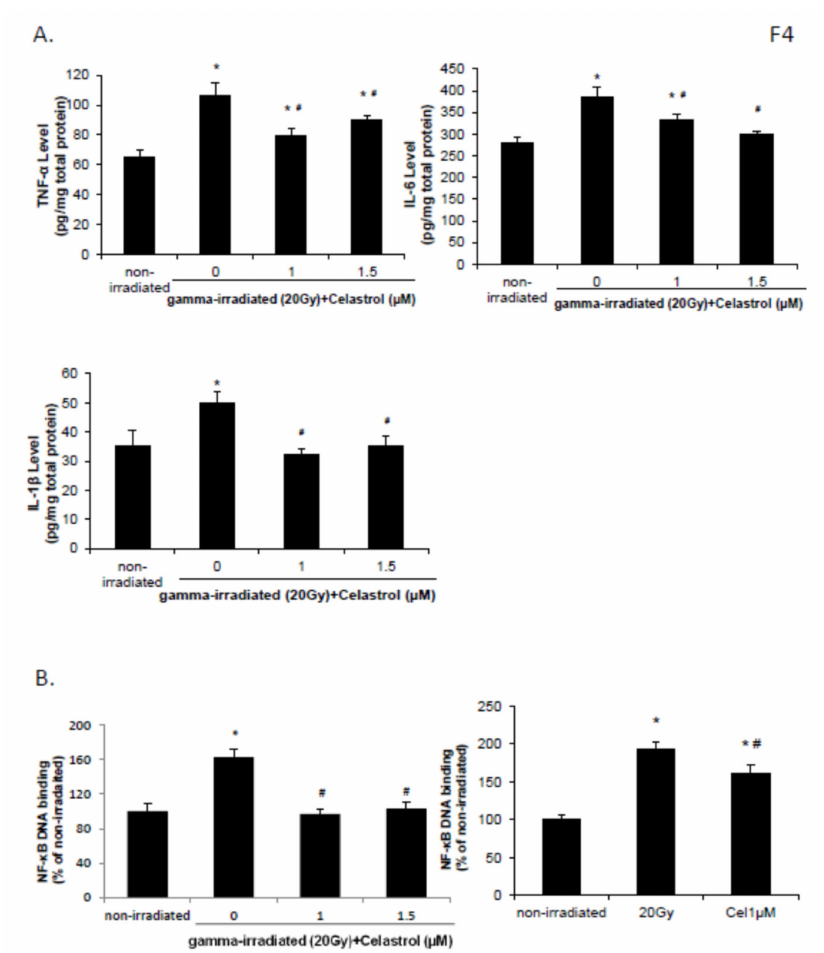
Figure 4. E ff ects of celastrol on the levels of inflammatory cytokines and NF- κ B activation. Cells were subjected to gamma irradiation with 20 Gy, followed by 24 h treatment with celastrol at designated concentrations. DMEM or EMEM group without any drug treatment and gamma radiation exposure served as control. ( A ) The levels of tumor necrosis factor alpha (TNF- α ), interleukin-6 (IL-6), and IL-1 β in HaCaT cell lysate were evaluated using ELISA. ( B ) NF- κ B DNA binding assay was performed 24 h post gamma-radiation in HaCaT (left panel) and human skin fibroblasts (right panel). All data are expressed as mean ± S.E.M ( n = 3). Comparisons between groups were analyzed by One-Way ANOVA followed by Tukey’s post-hoc test. * p < 0.05 vs. non-irradiated. # p < 0.05 vs. irradiated and no drug